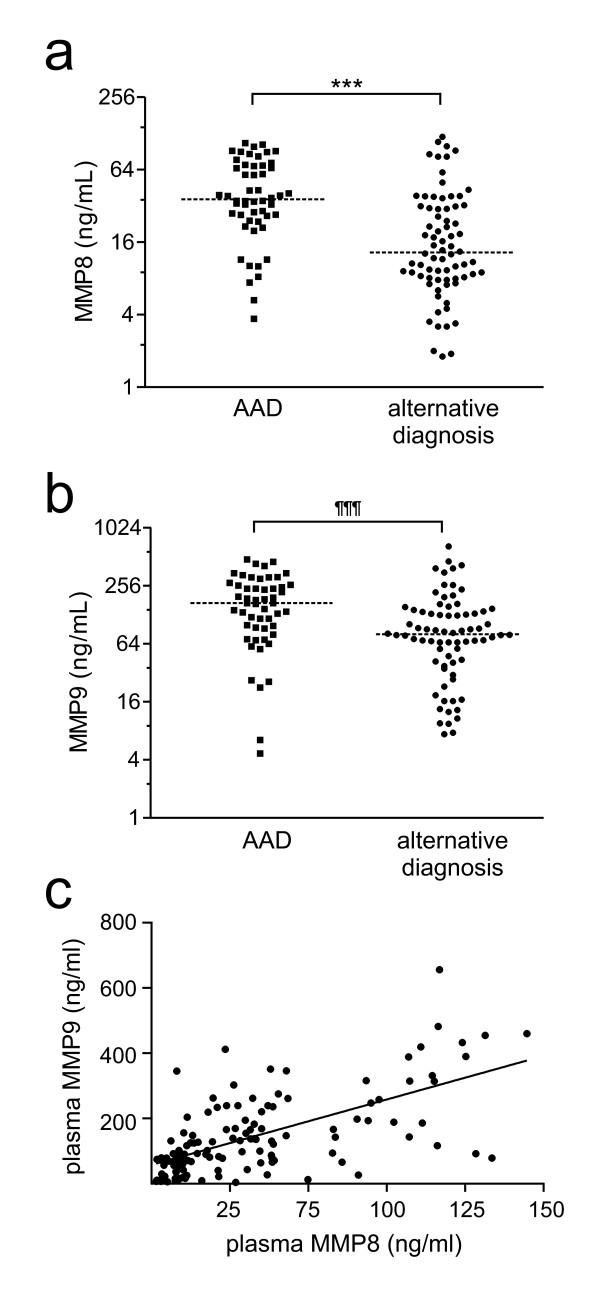
Plasma levels (ng/ml) of MMP8 (a) and MMP9 (b) in patients with acute aortic dissection (AAD) and in patients receiving a final alternative diagnosis. Y-axis: log2 scale. ***P <0.0001, ¶¶¶P = 0.0001 by nonparametric Mann-Whitney U test. (c) Correlation of plasma MMP8 and plasma MMP9 in enrolled patients. MMP, matrix metalloproteinase.